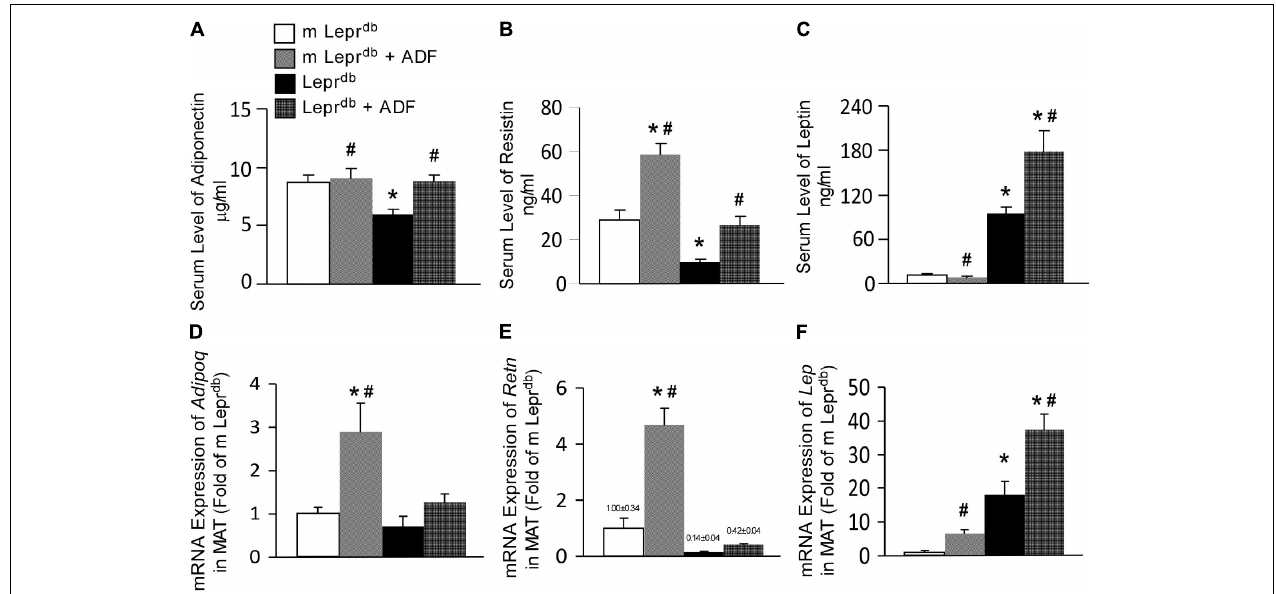
FIGURE 3 | ADF modulated circulating levels and adipose expression of key adipokines, including adiponectin, resistin, and leptin in mesenteric adipose tissue (MAT) of both m Lepr db and Lepr db mice. Circulating levels of adiponectin (A) , resistin (B) , and leptin (C) were determined by ELISA. mRNA expression of Adipoq (D) , Retn (E) , and Lep (F) were determined by qRT-PCR in mesenteric adipose tissue (MAT). Data represent mean ± SEM. n = 6 m Lepr db , 6 m Lepr db + ADF, 6 Lepr db , and 5 Lepr db + ADF. * P < 0.05 vs. m Lepr db control mice, # p < 0.05 vs. Lepr db diabetic